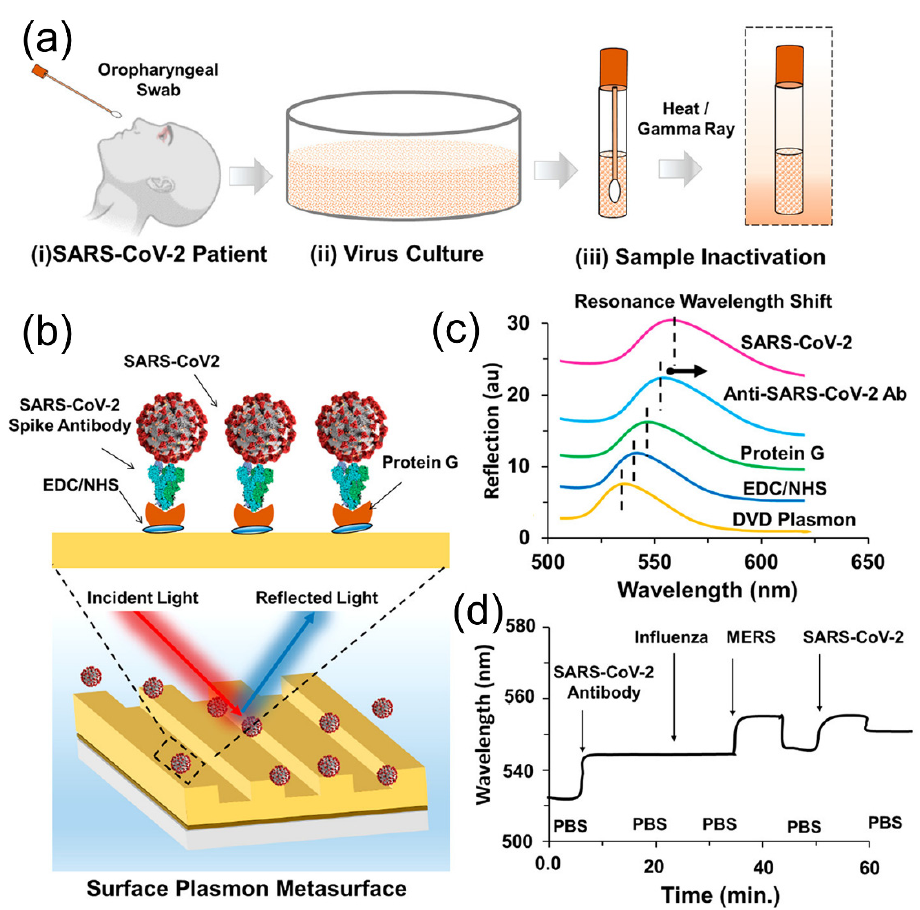
Figure 9. Plasmonic metasurface sensor based on periodic structures for SARS-CoV-2 detection and biosensing. ( a ) Schematic illustration of SARS-CoV-2 sample collection, virus culture, and heat or gamma irradiation steps for inactivated virus preparation. ( b ) Schematic illustration showing the surface plasmon resonance-based SARS-CoV-2 detection. ( c , d ) Optical response of the proposed sensor is based on the resonance wavelength shift based on molecular binding that allows differential identification of SARS and influenza from their specific and nonspecific binding events. Reprinted from [179], with permission from American Chemical Society.